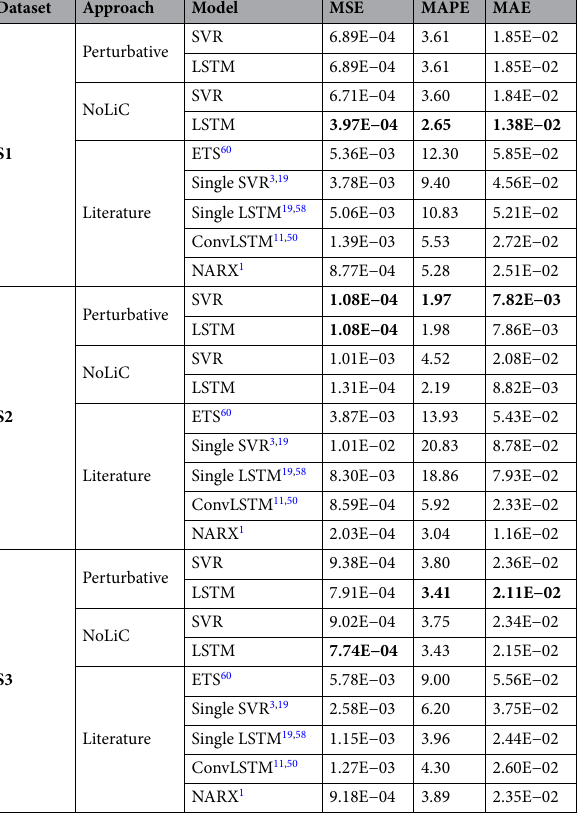
Table 4. Comparison in terms of MSE, MAPE, and MAE of the combination approaches with single statistical and Machine Learning models of the literature applied to the SST daily forecasting. For each data set, the best value of the metrics is highlighted in